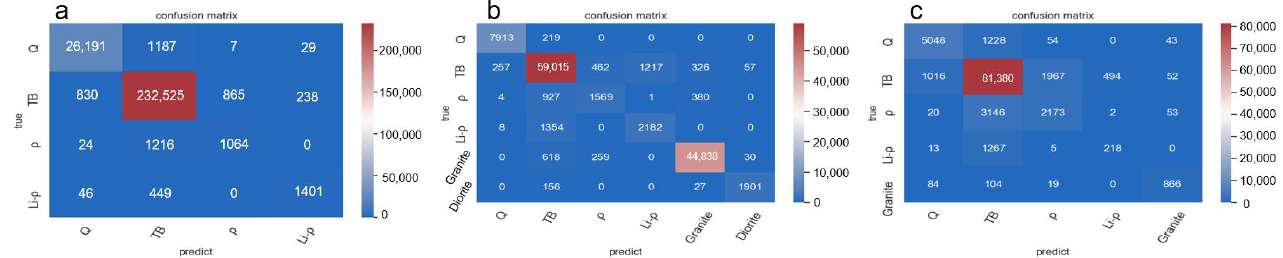
Figure 16. Confusion matrix for the RF classifiers. The rows and columns of the matrix represent the actual and predictive lithologic units, respectively: ( a ) Akesayi mine, ( b ) 509 mine, ( c ) Longmengshan